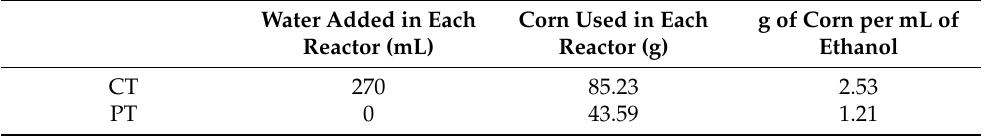
Table 1. Water added, corn used, and grams of corn need to produce one milliliter for ethanol for the corn treatment (CT) and the proposed treatment